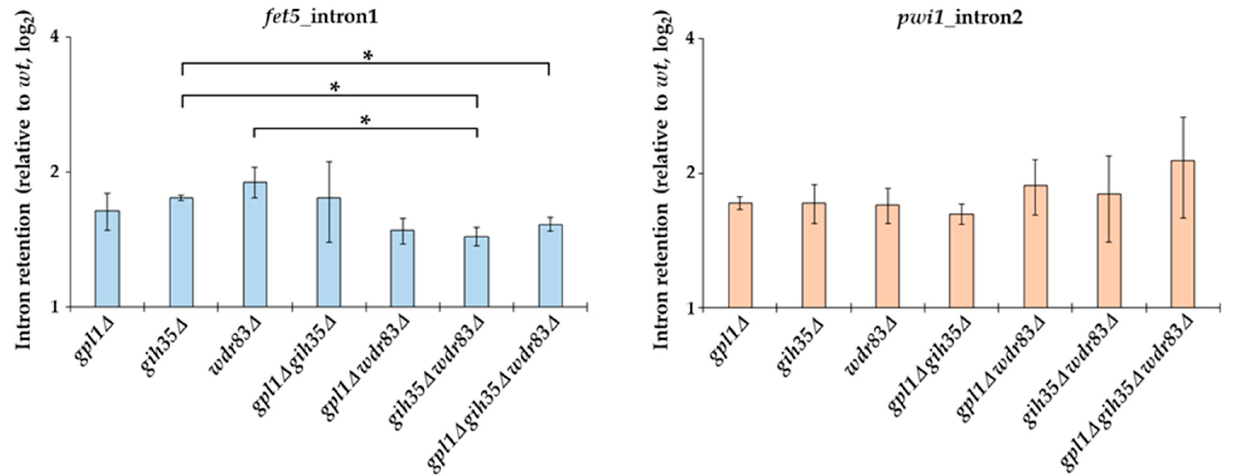
Figure 6. RT-qPCR analysis of splicing efficiency in Gpl1-Gih35-Wdr83 complex deletion mutants. The intron retention relative to wild type (wt level was normalized to 1) is shown for the first intron of fet5 and the second intron of pwi1. The data represent mean values ± SEM of intron retention relative to wild type from three independent biological replicates. Statistical significance of intron retention of studied genes was determined using two-tailed Student’s t -test ( p -values: *— p ≤ 0.05).